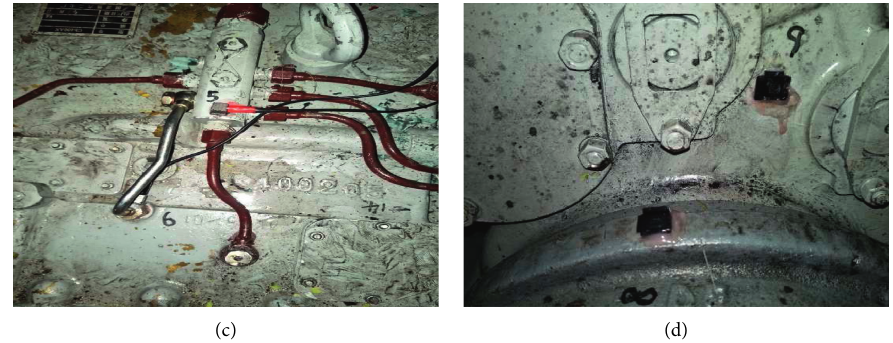
Figure 14: Measuring point locations. (a) Point 2 (upper part of Mount). (b) Point 3 (lower part of Mount). (c) Point 5 (top oil pipe). (d) Point 8 (easily damaged lubricating oil position).